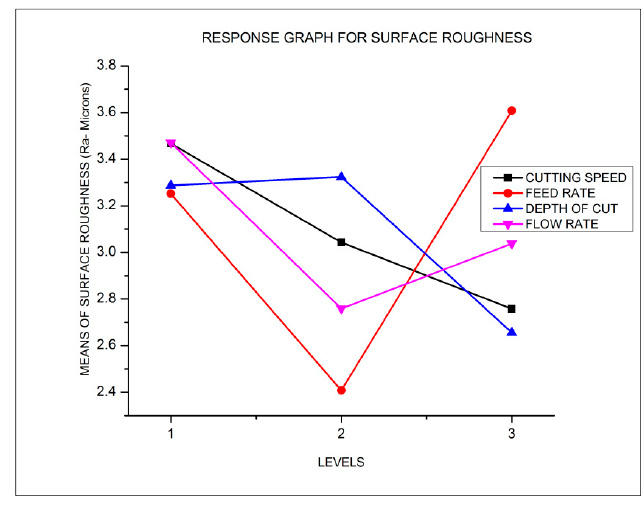
Figure 4. Analysis on surface roughness. Table 6. Response table for surface roughness.